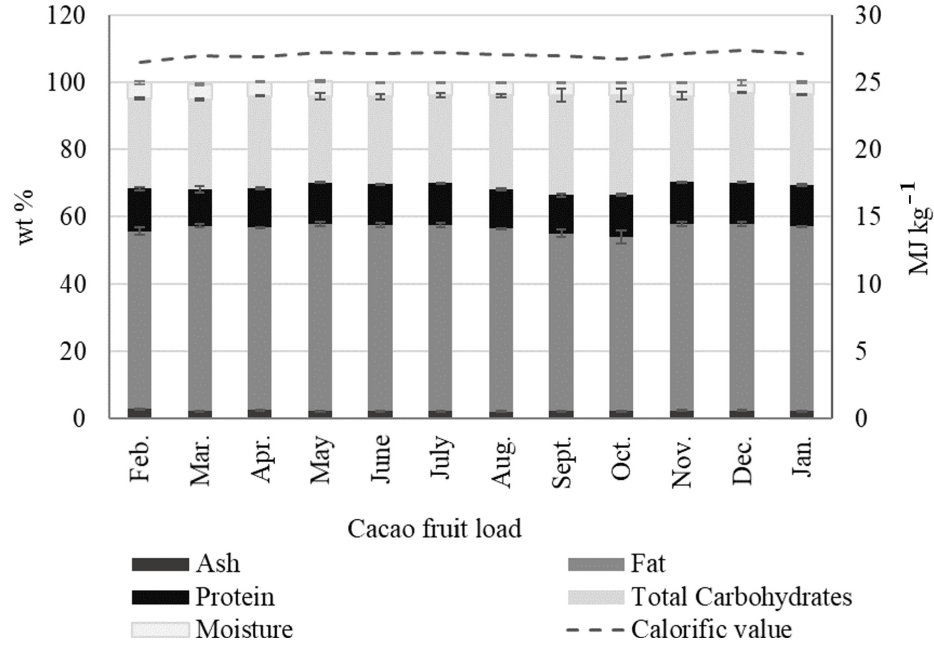
Figure 8. Seasonal variations in the proximate analysis of fermented and dried cacao beans (CB) from Colombian CCN51 cacao fruit.